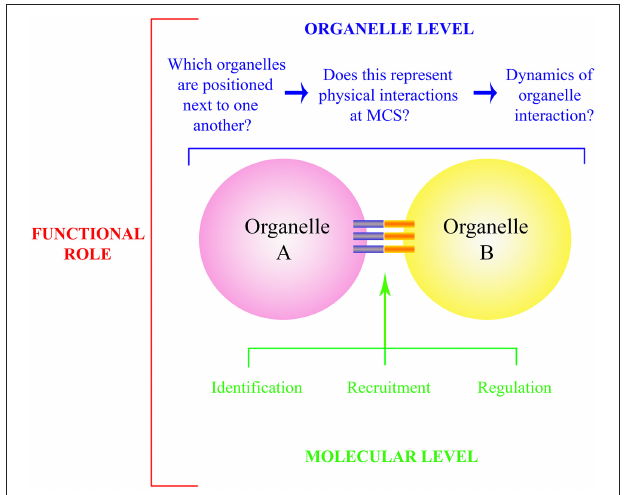
FIGURE 1 | Schematic representation of questions relating to organelle interactions and MCS. The functional role of organelle interaction (red) is determined at the whole organelle (blue) and molecular level (green). At the organelle level, bona fide physical interactions need to be identified, and the regulation of such is governed through identification, recruitment and regulation of the molecular components that comprise the MCS itself (blue and orange bars). These components include both physical tethers and those which allow exchange at the MCS.